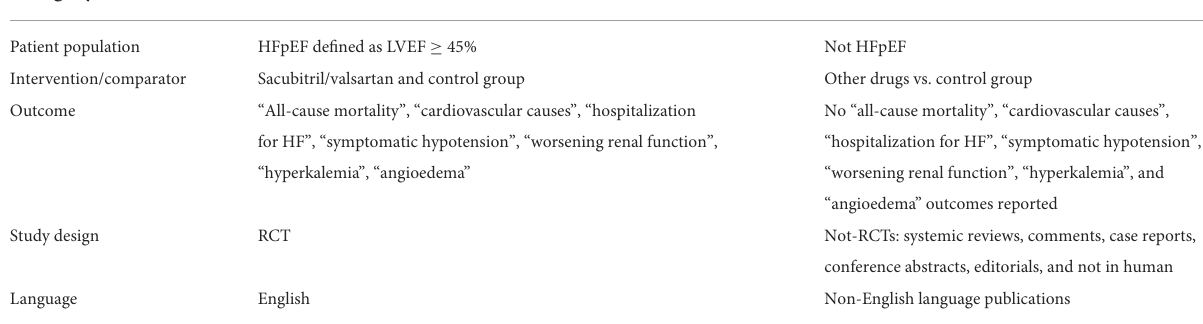
TABLE 1 Inclusion and exclusion